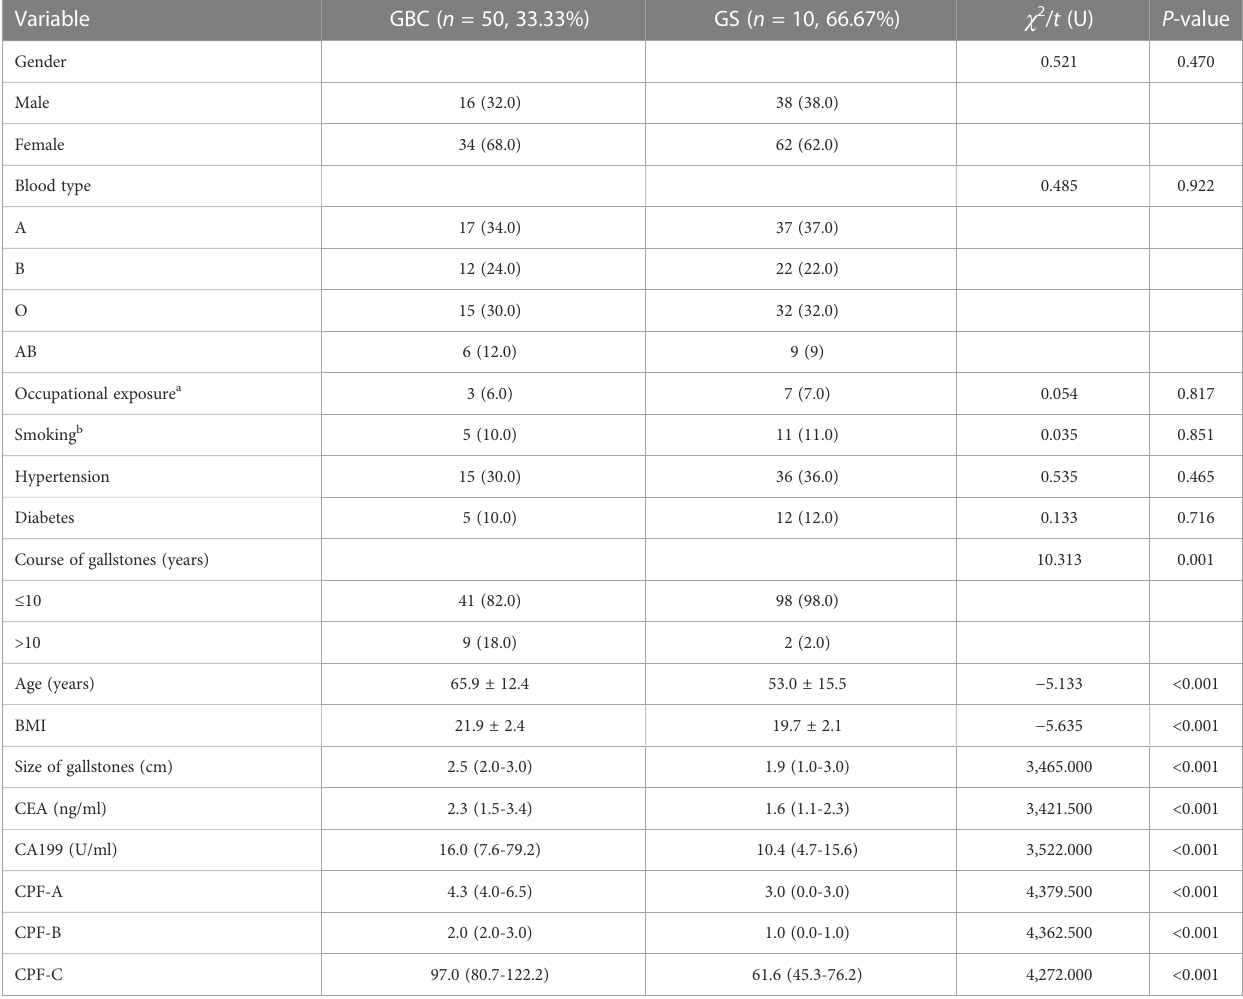
TABLE 5 Comparison of general data between GBC and GS in the external validation